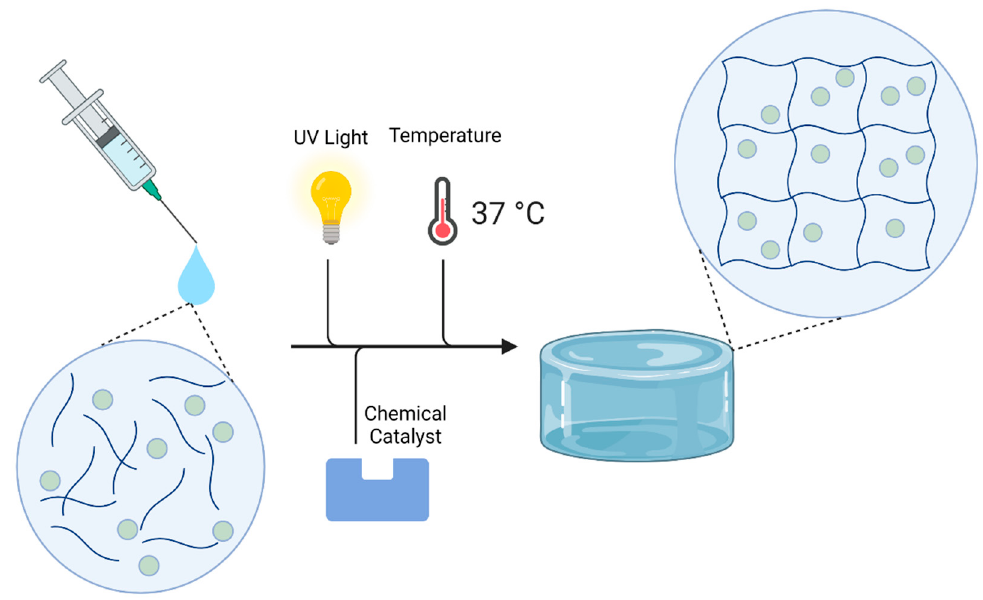
Figure 6. A syringe containing a hydrogel solution with a drug can be stimulated by UV light, temperature, or catalyst to begin the gelation process in situ. Table 3. Hydrogel drug delivery devices developed for the treatment of GBM. Details the hydrogel matrix, drug carrier system, drug encapsulated, and crosslinking